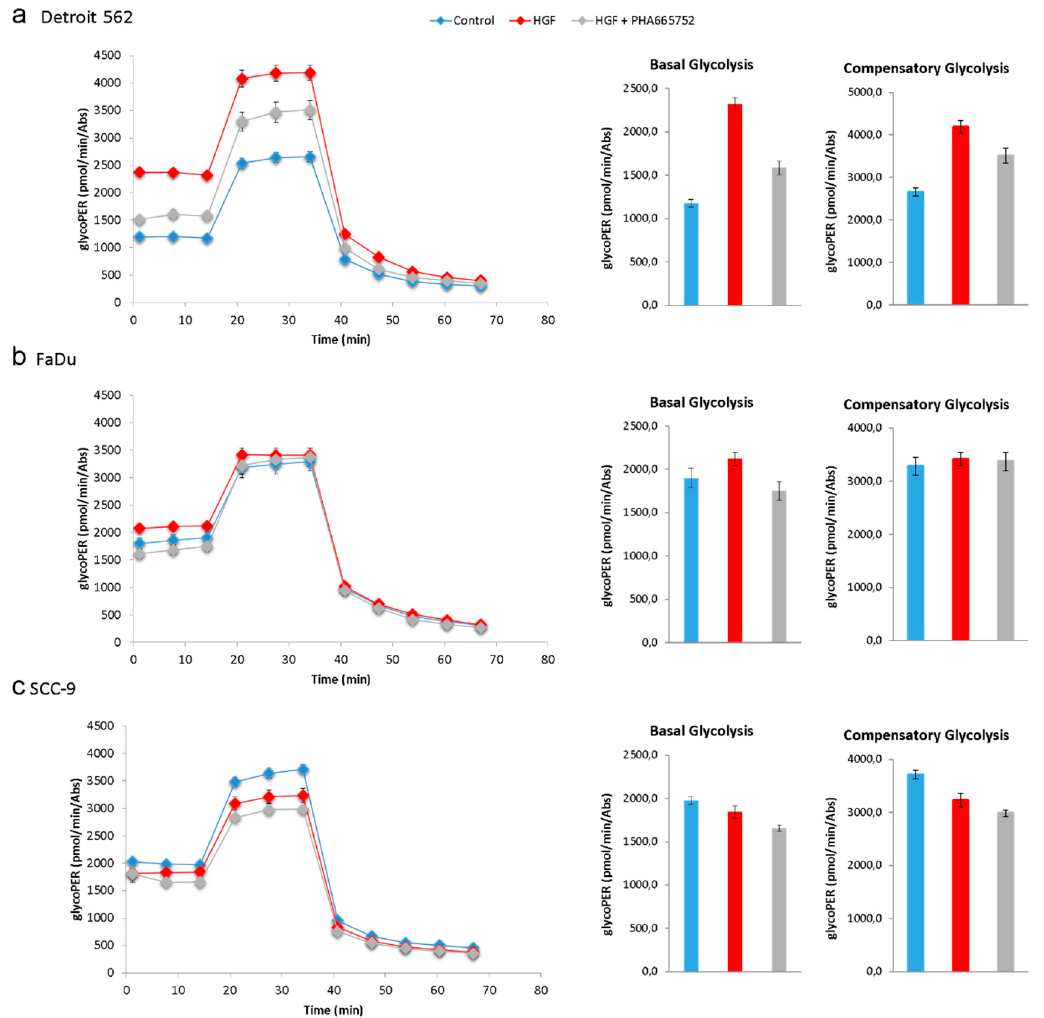
Figure 8. Glycolytic proton efflux is increased upon HGF stimulation in Detroit 562 cells. Detroit 562 ( a ), FaDu ( b ) and SCC-9 cells ( c ) were stimulated with 50 ng/mL HGF (red), 50 ng/mL HGF, and 50 µg/mL PHA-665752 (grey) or neither (Control, blue). After 48 h, the glycolytic proton efflux rate (glycoPER) was measured. On the left side, kinetic graphs are shown with eleven datapoints from left to right. First, basal glycolysis was measured (first three datapoints), and mitochondrial function was inhibited using an injection of rotenone A and antimycin A (after measurement 3). Measurements 4–6 were used to measure compensatory glycolysis. To prove that the measured proton efflux was mainly produced by glycolysis, glycolysis inhibitor 2-DG was injected after measurement 6, resulting in a rapid decline of proton efflux (datapoints 7–11). On the right side, glycoPER values for basal and compensatory glycolysis are shown as bar charts (corresponding to values of datapoints 3 and 6 in the kinetic graphs). Raw data were normalized using absorbance at 595 nm of crystal violet-stained cells. Datapoints are means with SEM, n = 10. A typical experiment out of at least three is shown.